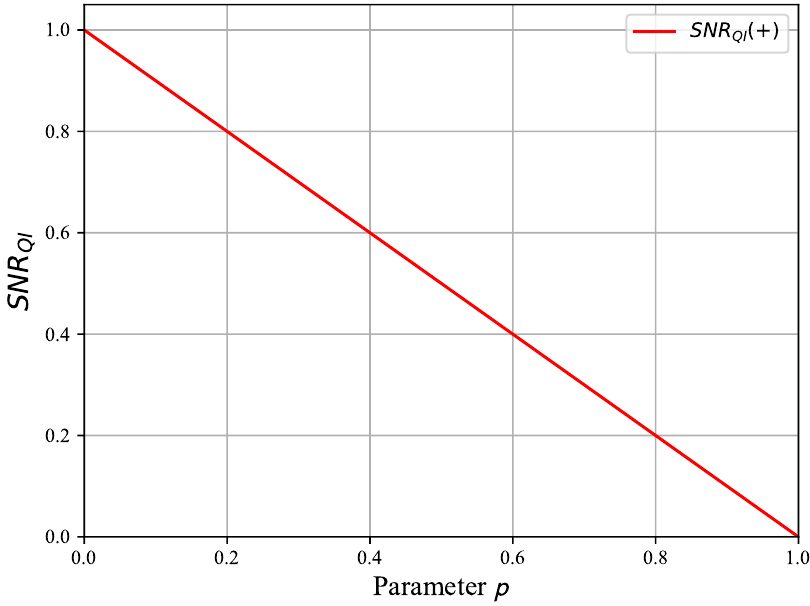
Figure 8. The SNR + in the QI radar as a function of the parameter p ∈ [ 0, 1 ] with n b calculated for f = 5 × 10 14 Hz. The SNR has been normalized by its maximum because as the noise n b (cid:28) 1 , the SNR is huge for small values of p